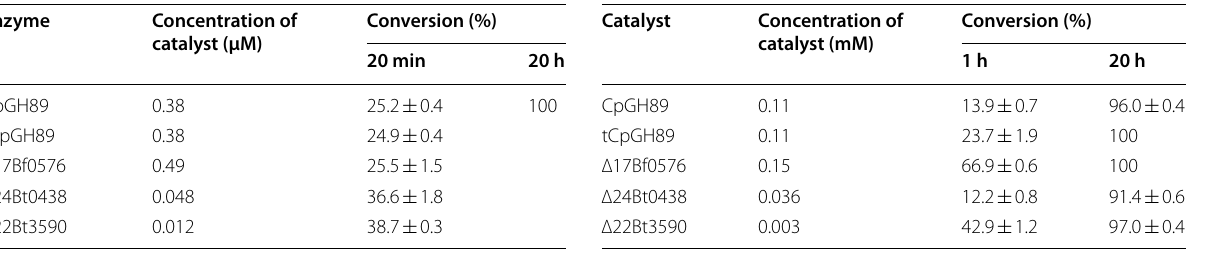
Table 2 Activity comparison Table 3 Activity comparison of recombinant bacterial α‑ N